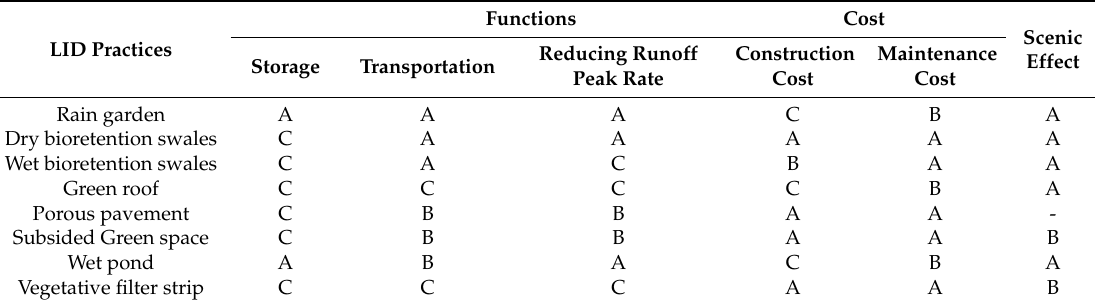
Table 1. Comparison of some Low Impact Development (LID) practices